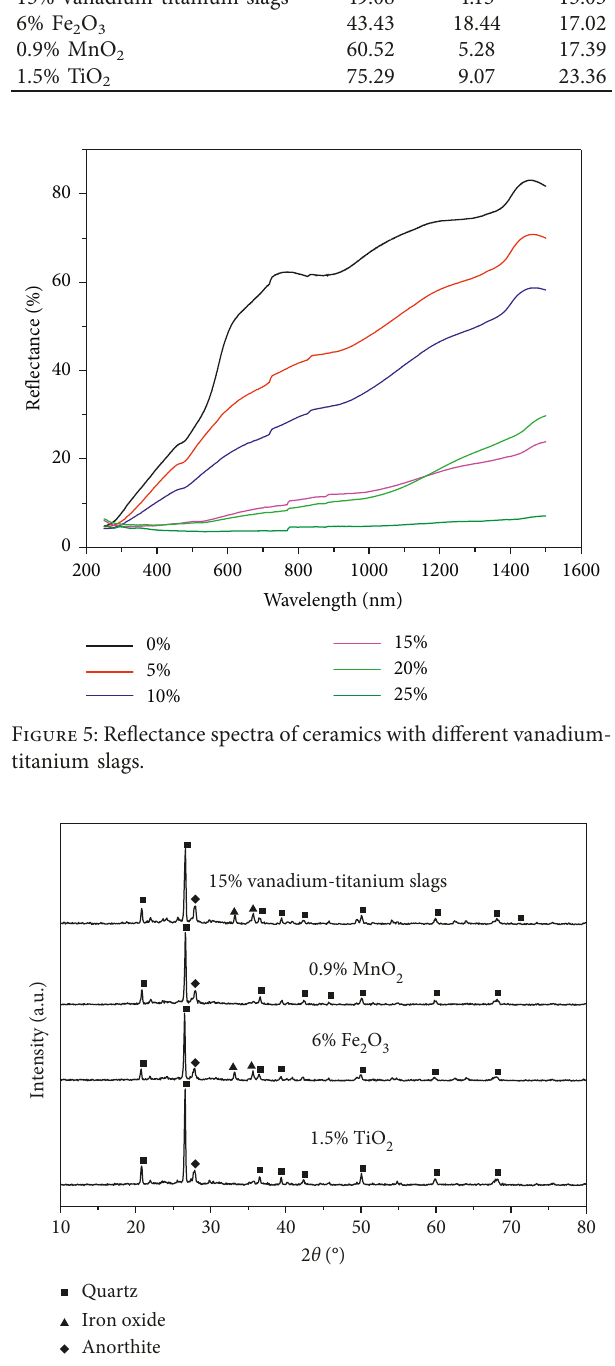
Figure 6: XRD spectra of ceramics with different additions at sintering temperature of 1100 °